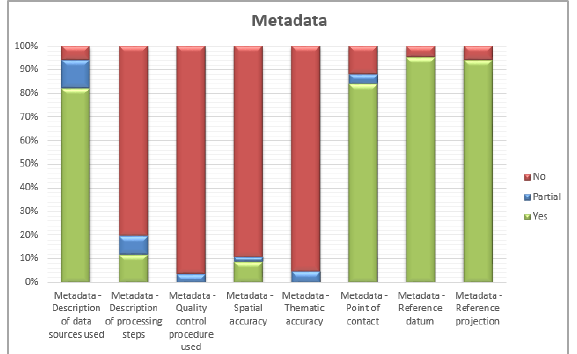
Figure 5. Presence of information regarding metadata from 2005 to 2010 (Carrion et al. 2013)